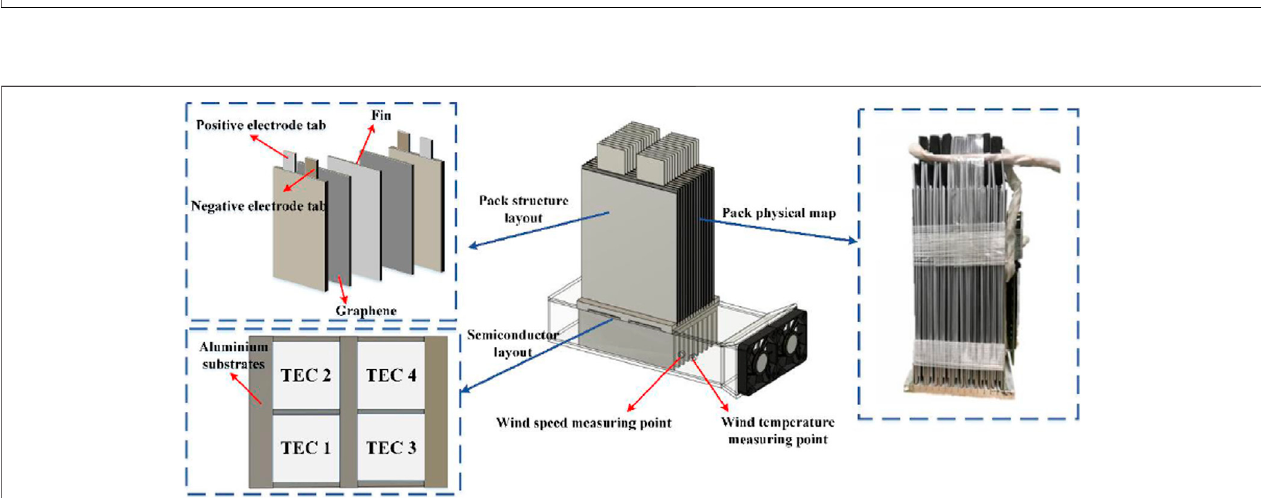
FIGURE 6 | Temperature evolution at the hot and cold ends at different